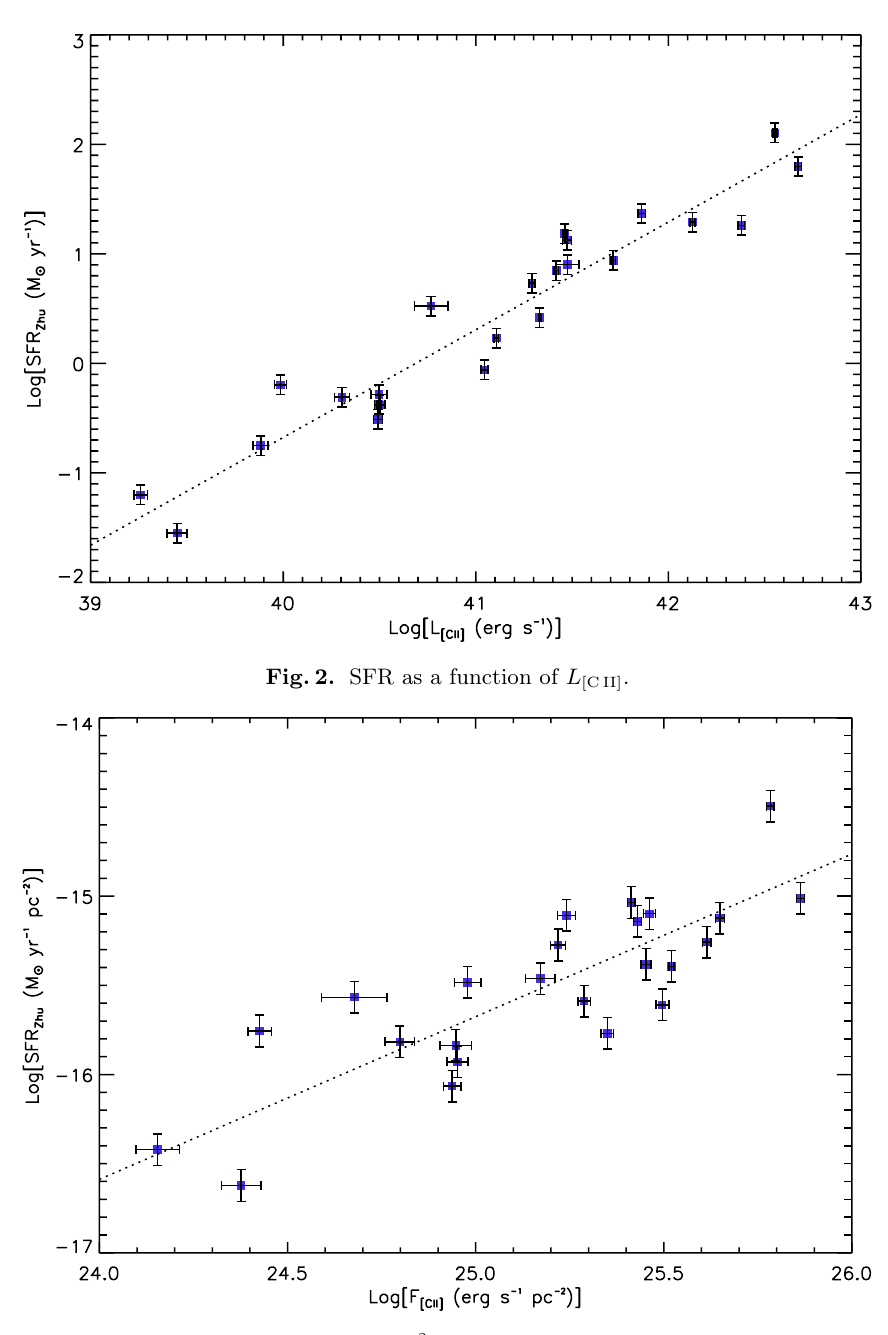
Fig. 3. SFR/4 (cid:25)D 2 as a function of F [CII]